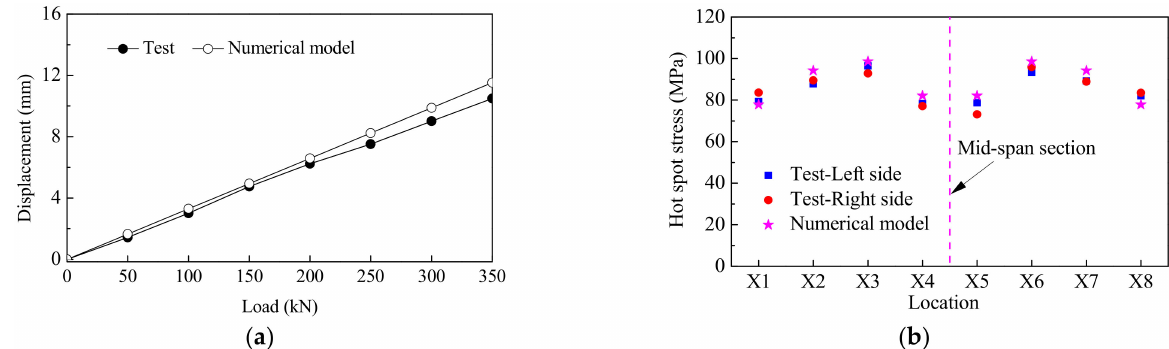
Figure 18. Mesh convergence analysis.